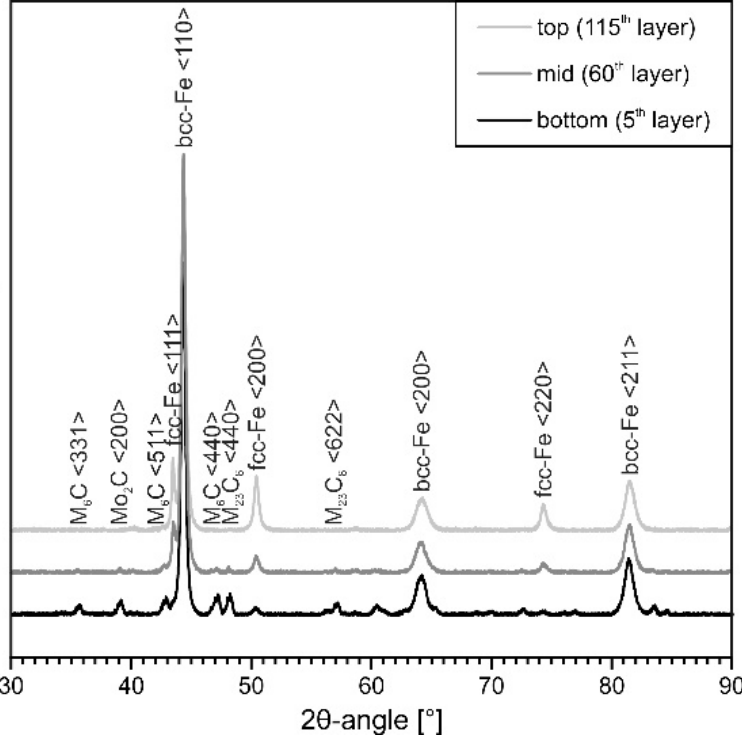
Figure 8. Diffraction patterns at the bottom, mid and top of continuously processed tool steel X36. Table 8. Volume fractions of RA at bottom, mid and top of continuously processed tool steel X36. Layer Position Layer No. Volume Fractions of Retained Austenite Position no.